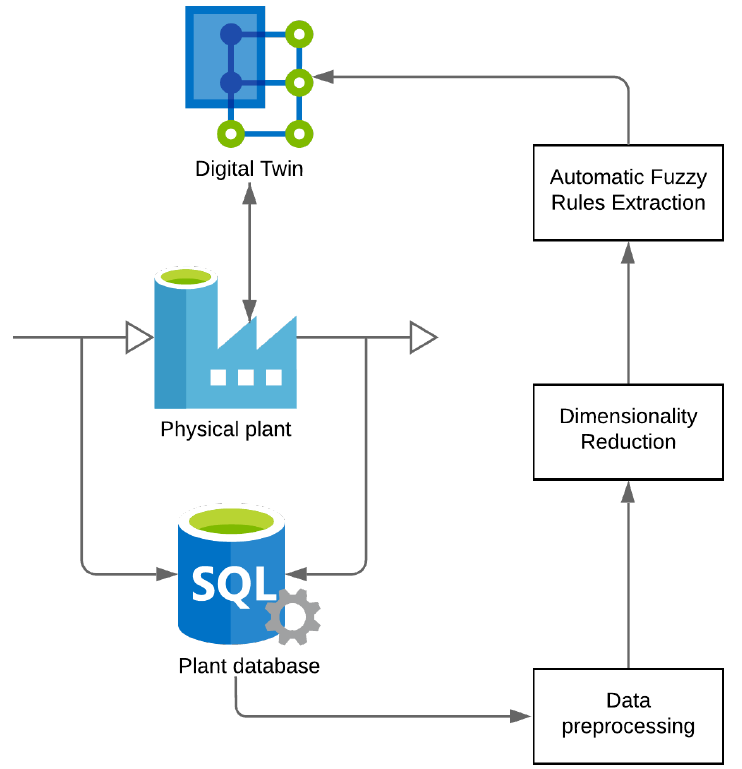
Figure 4. Block diagram of digital